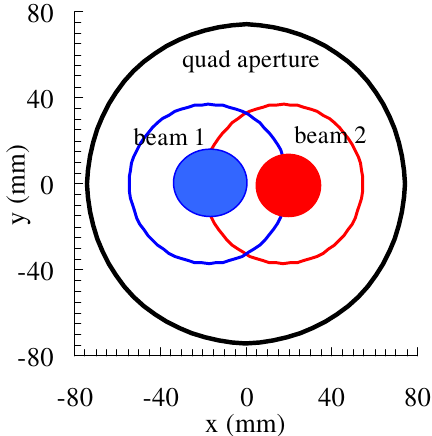
FIG. 11. (Color) Sketch of the beam location in the IR quadru- pole, doubling the quadrupole aperture and reducing (cid:1) (cid:1) with respect to Fig. 10.